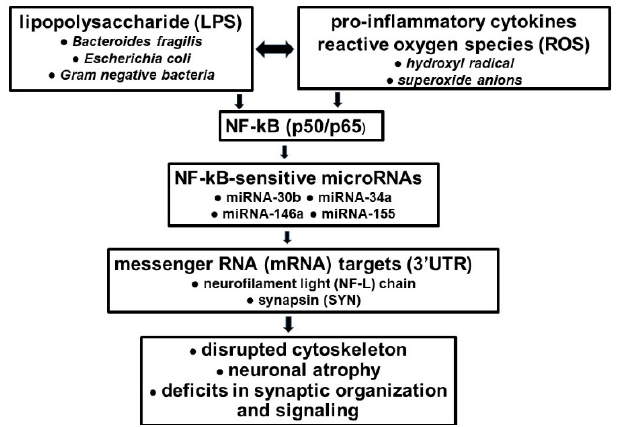
Figure 2. Highly schematized flow chart of a pathological circuit in AD brain flowing along the gut–brain axis (see manuscript text). The interactions among GI-tract-microbiome-derived LPSs, pro-inflammatory cytokines and ROS in the generation of the pro-inflammatory transcription factor NF-kB (p50/p65) complex are not completely understood; other miRNAs and mRNAs are expected to be involved in this pathological cascade; importantly, the GI-tract microbiome provides a long-term and life-long source of LPSs; specific components of this pathological pathway provide multiple therapeutic targets for the more effective clinical management of AD.